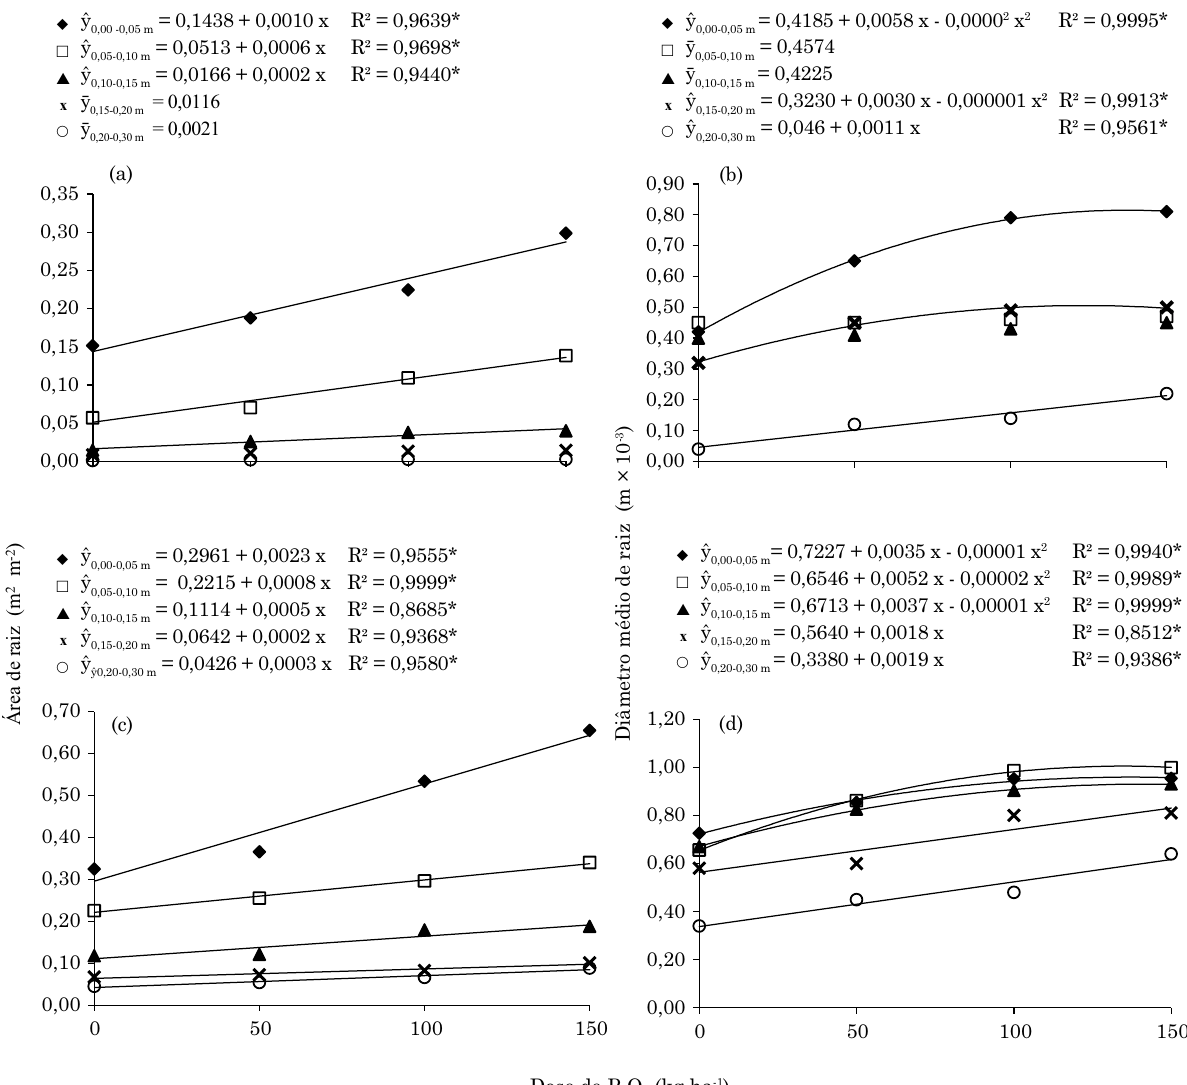
Figura 6. Área e diâmetro de raiz da soja (a, b) e do milho (c, d) em diferentes camadas de solo em função das doses de P na adubação. * significativo pelo teste F